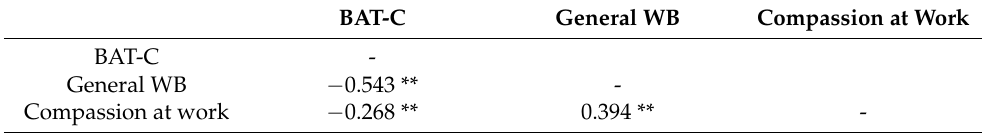
Table 1. Average Variance Extracted and Composite Reliability. AVE CR BAT-C 0.69 0.89 General WB 0.68 0.91 Compassion at work 0.75 0.90